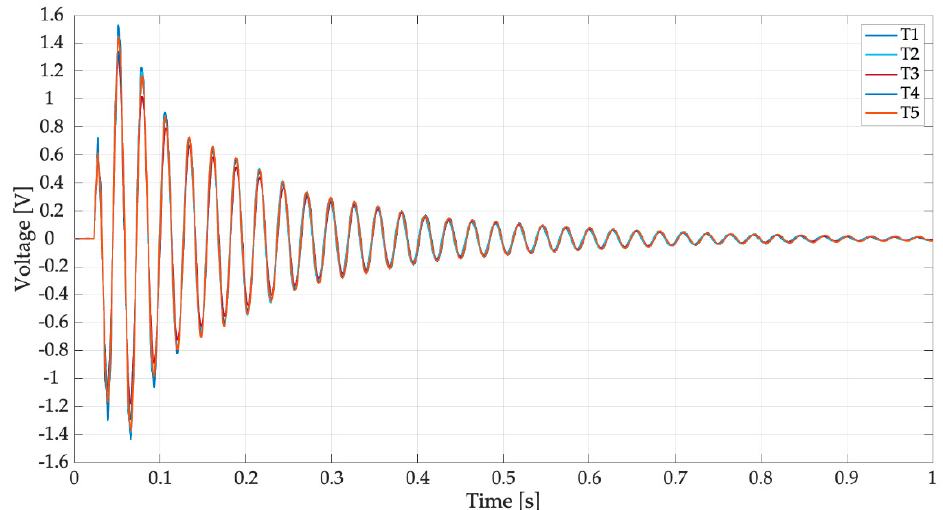
Figure 17. Tests with drops falling from 1 m on the filled spoon, on-load voltage.